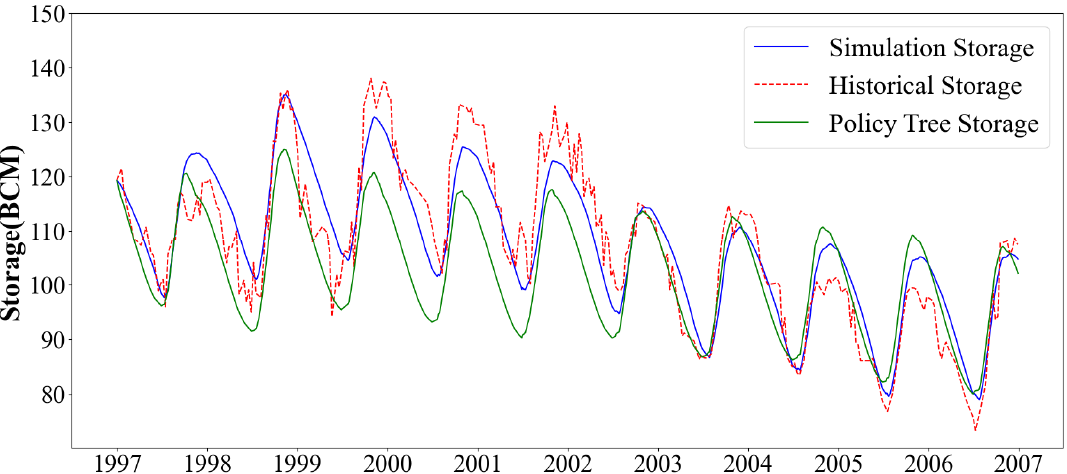
Figure 14. Simulation and policy tree optimization lake storage results compared with historical data.